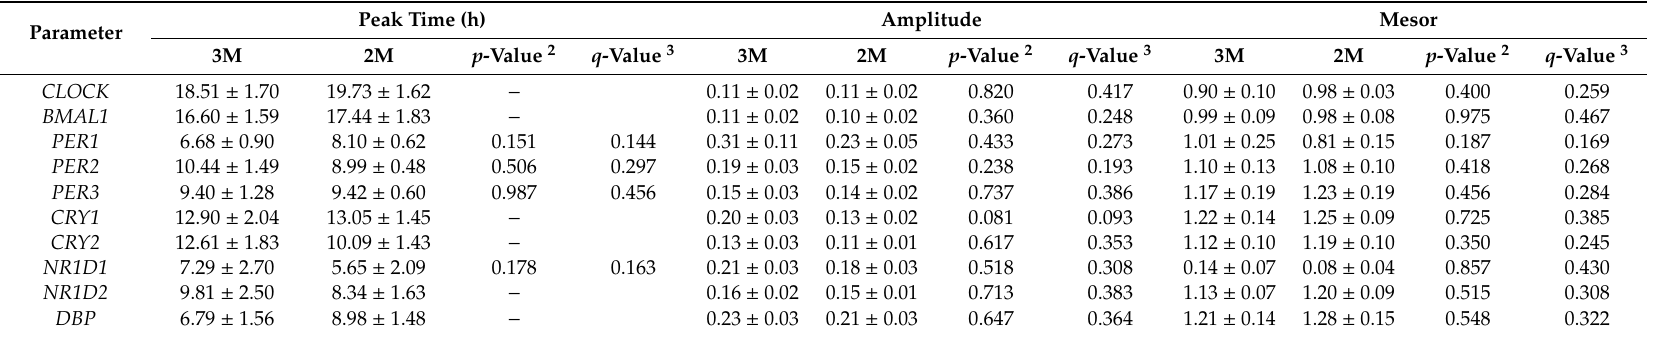
Table 1. Comparison of clock genes by cosinor fitting